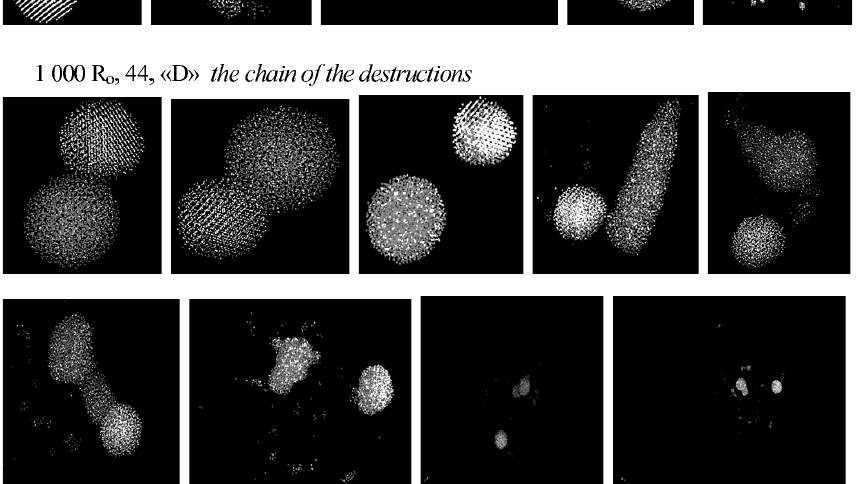
Fig. 2. Examples of the final states of the CBS of the MR Cyg type after the peri- center passage near the super-massive black hole with the mass 10 6 M ⊙ , obtained in the calculations for different pericenter distances ( r p = 85 ; 150 ; 500 ; 1000 R ⊙ ). The final states are labeled ‘M’ (merging of the components), ‘D’ (destruction of the components). Numbers refer to the series of computations presented in Table